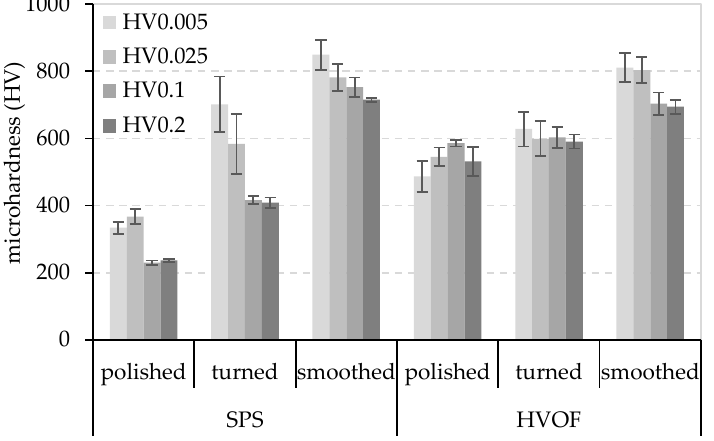
Figure 3. Surface microhardness of X120Mn12 SPS and HVOF specimen in relation to surface condition and the indention force.